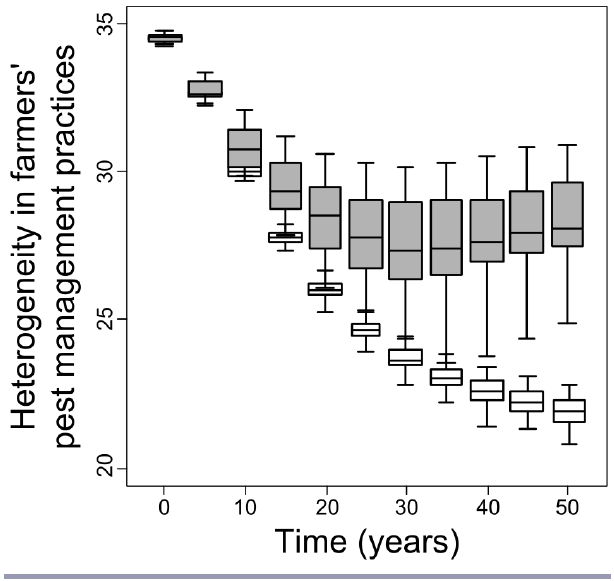
Fig. 4 . Evolution of heterogeneity in farmers’ pest management practices. The standard deviation in pest management practices for all farmers in a simulation was used to represent heterogeneity. Standard deviations were represented using boxplots (30 repetitions) without temperature variability in white, and with temperature variability in grey. After 25 years with temperature variability, heterogeneity in pest management practices stabilized. In contrast, it continued to decrease when there was no temperature variability, leading to homogenization of pest management